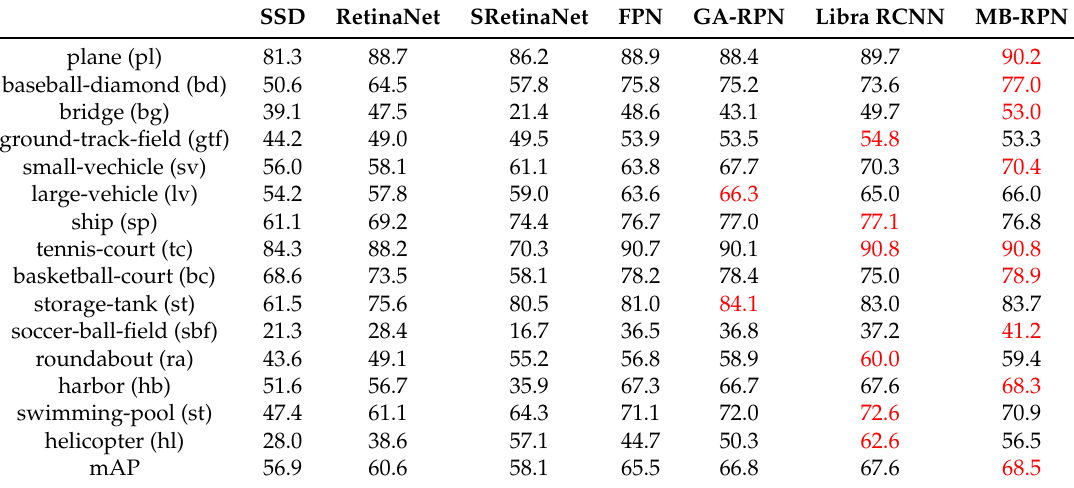
Table 2. Quantitative performance(AP%) of our model on DOTA benchmark datasets compared with comparison approaches. The best performance on each category is colored in